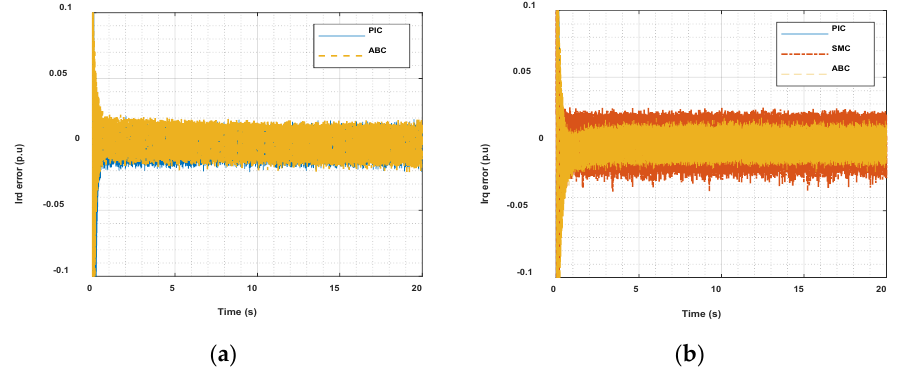
Figure 17. Rotor current error under 50% step increase in rotor and stator resistances; ( a ) Direct, ( b ) quadrature.